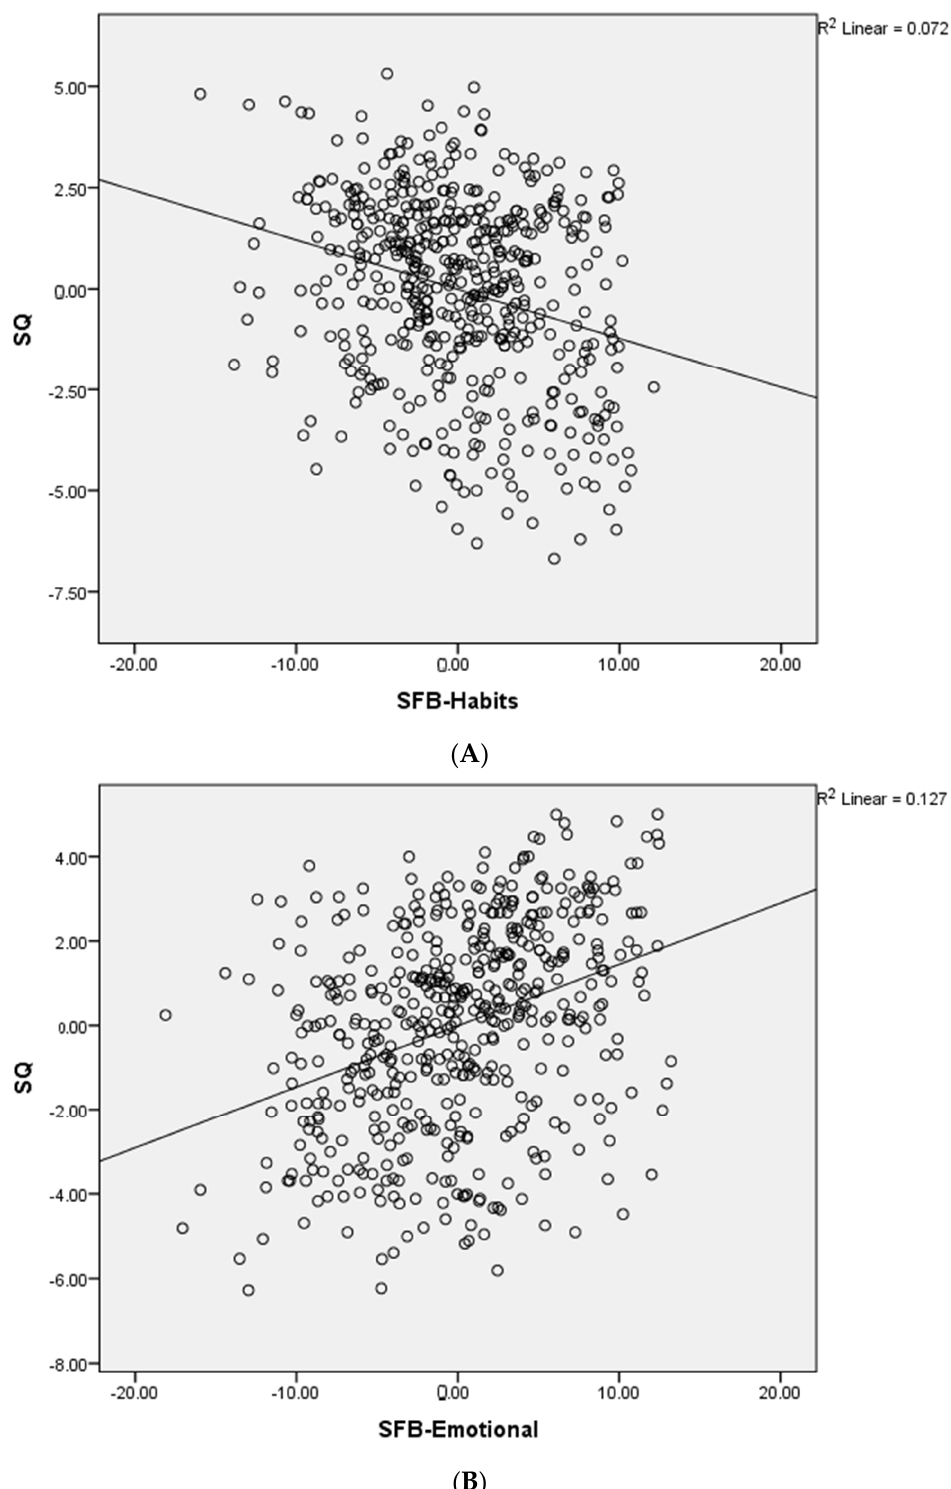
Figure 2. ( A , B ). Partial regression plots using sleep quality as the dependent variable; Note: SQ, sleep quality. SFB-Habits, socio-familial habits. SFB-Emotional, socio-familial emotional. Table 5. Descriptive statistics for socio-familial behavior and sleep quality measures.